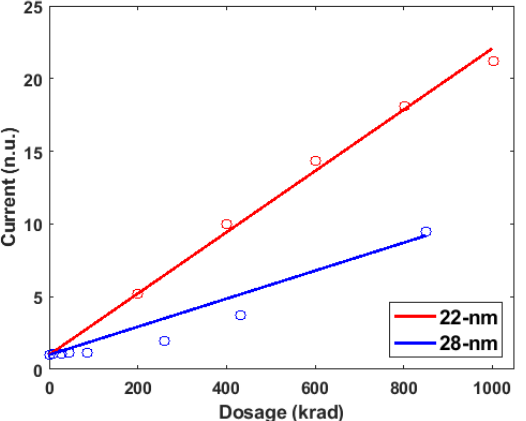
Figure 11. Current from 22-nm and 28-nm tests during Co-60 test.